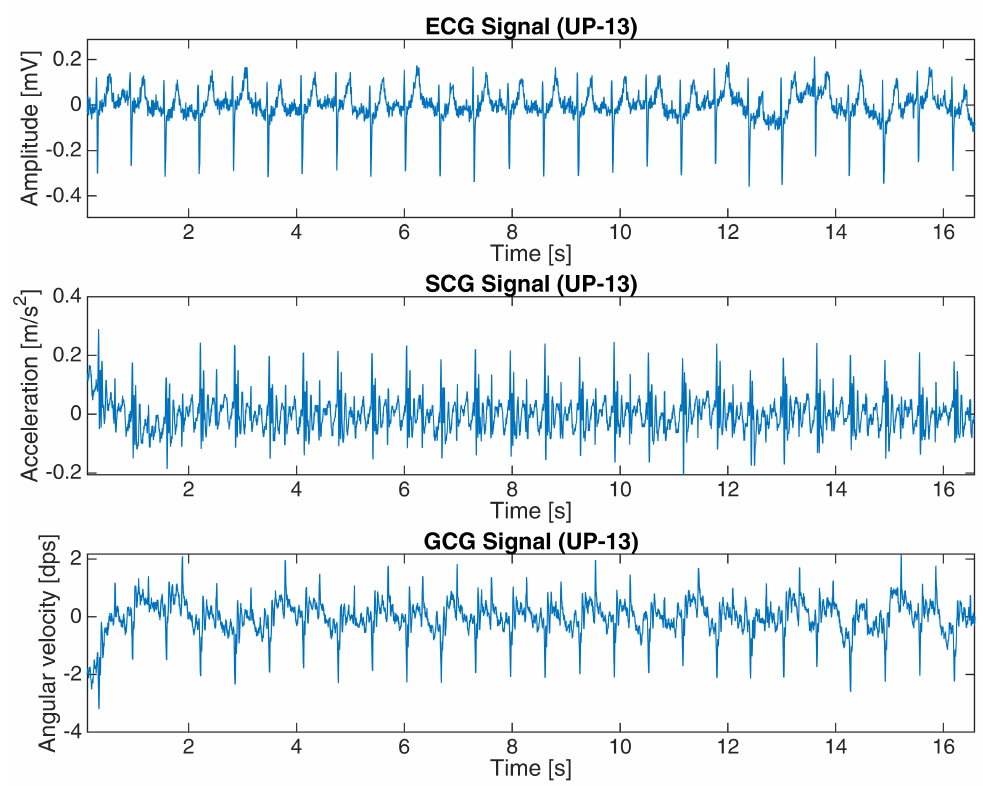
Figure 3. ECG, SCG and GCG signals from subject UP-13 in the second dataset (16-s